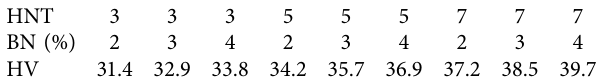
Table 2: Composition of aAluminum MMC with